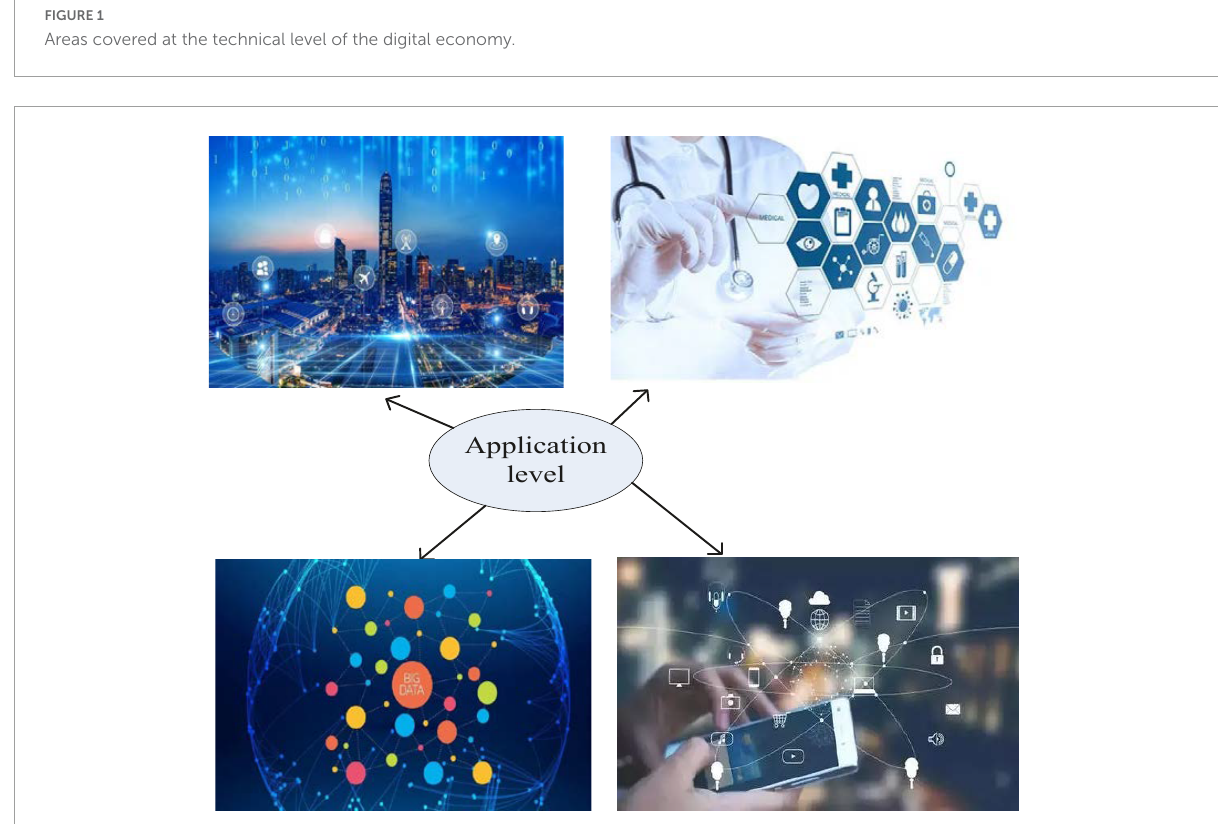
FIGURE2 The areas covered by the application level of the digital economy.